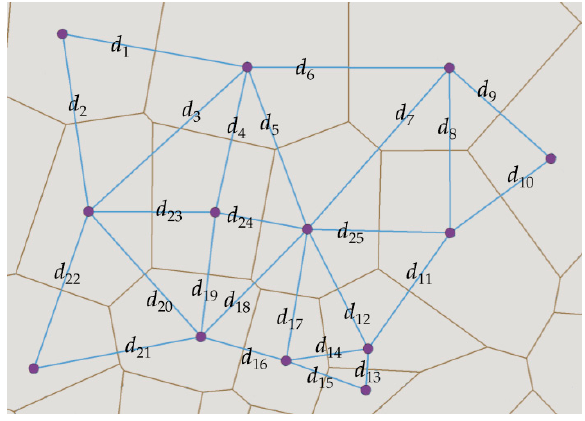
Figure 4. The calculation example of Eps .